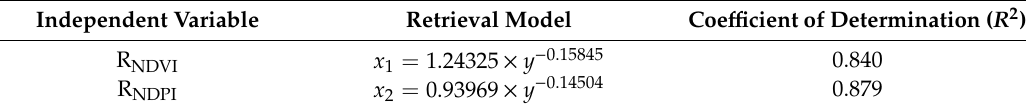
Table 4. Foliar absorbed dust inversion model.